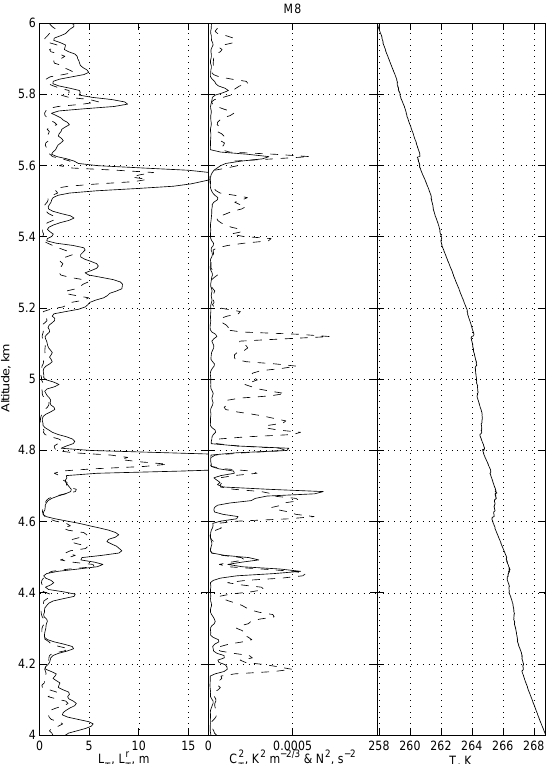
Figure 3. Examples of (left) directly measured (solid line) and indirect (dashed line) Thorpe Fig. 3. Examples of (left) directly measured (solid line) and indirect length and corresponding values (center) of C T2 (solid line) and N 2 (dashed line) and (dashed line) Thorpe length and corresponding values (center) of temperature (right) for flight M8 in the troposphere. C 2 (solid line) and N 2 (dashed line) and temperature (right) for T flight M8 in the